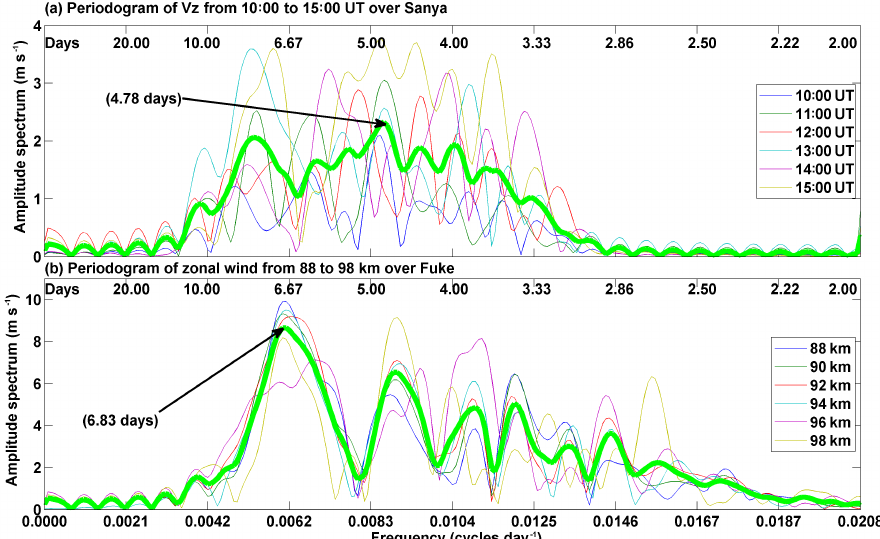
Figure 7. The Lomb–Scargle amplitude spectrum of the vertical drifts in the ionosphere (a) and that of the zonal winds at 88–98km in the MLT region (b) . The thin lines with different colors denote the amplitude spectrum lines from 10:00 to 15:00UT (the upper panel) and from 88 to 98km (the lower panel). The thick green line denotes the mean spectrum in the two